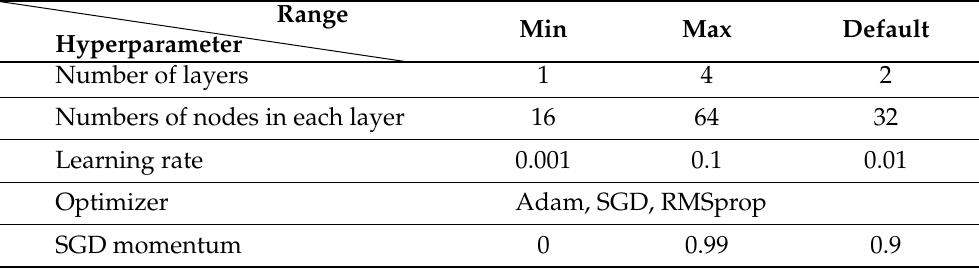
Table 2. Search space of the DQN hyperparameters to be optimized using the BOHB